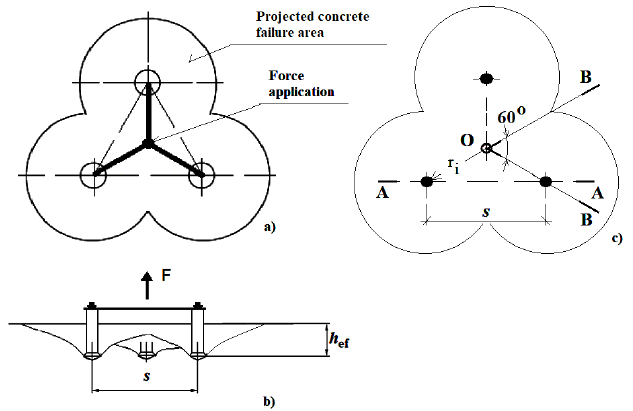
Figure 3. The layout and loading of the 3-anchor system ( a ), ÷ ( b ), ( c ) a BOB section—a sixth of the model serving as the basis for the FEM-3D model of the 3-anchor system, s —anchor spacing equal to the 2-anchor system, r i —radius of anchor spacing.